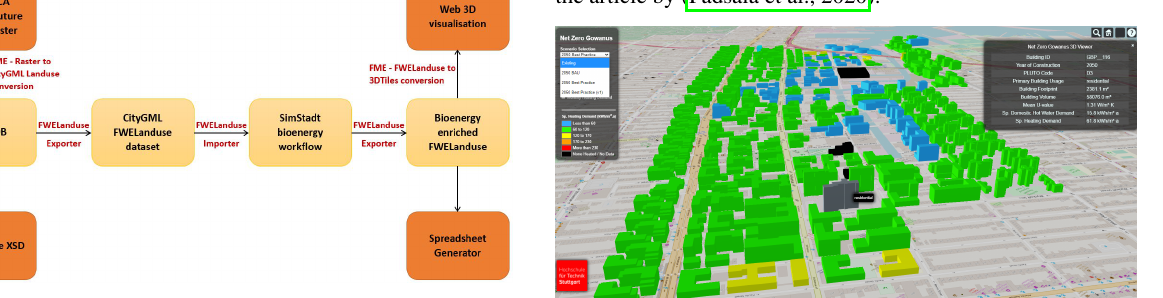
Figure 18. Gowanus’ best practise 2050 scenario visualised with its heating